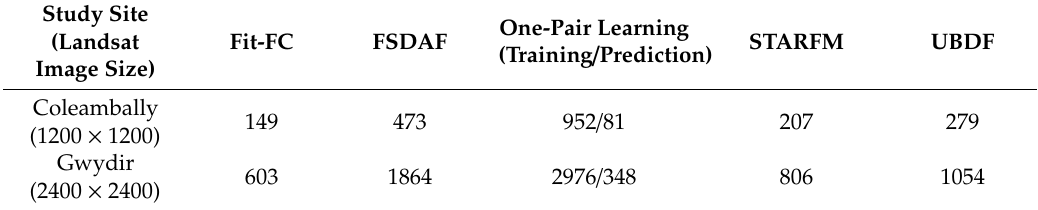
Table 3. Comparison of model runtime (unit: seconds) of the five models for two study